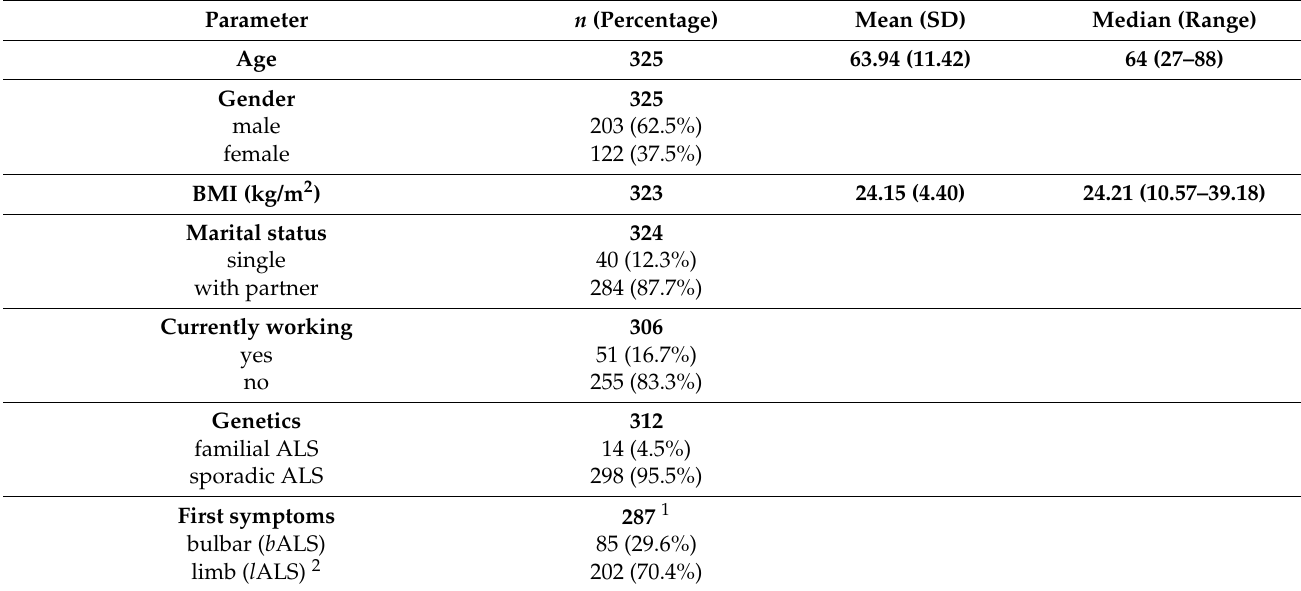
Table 1. Characteristics of the ALS patient cohort and the mean overall and individual question results of the quality of life (QoL) questionnaires, with n representing the number of patients who answered the specific question. The bold text refers to the heading of the question, whilst the roman text represents the